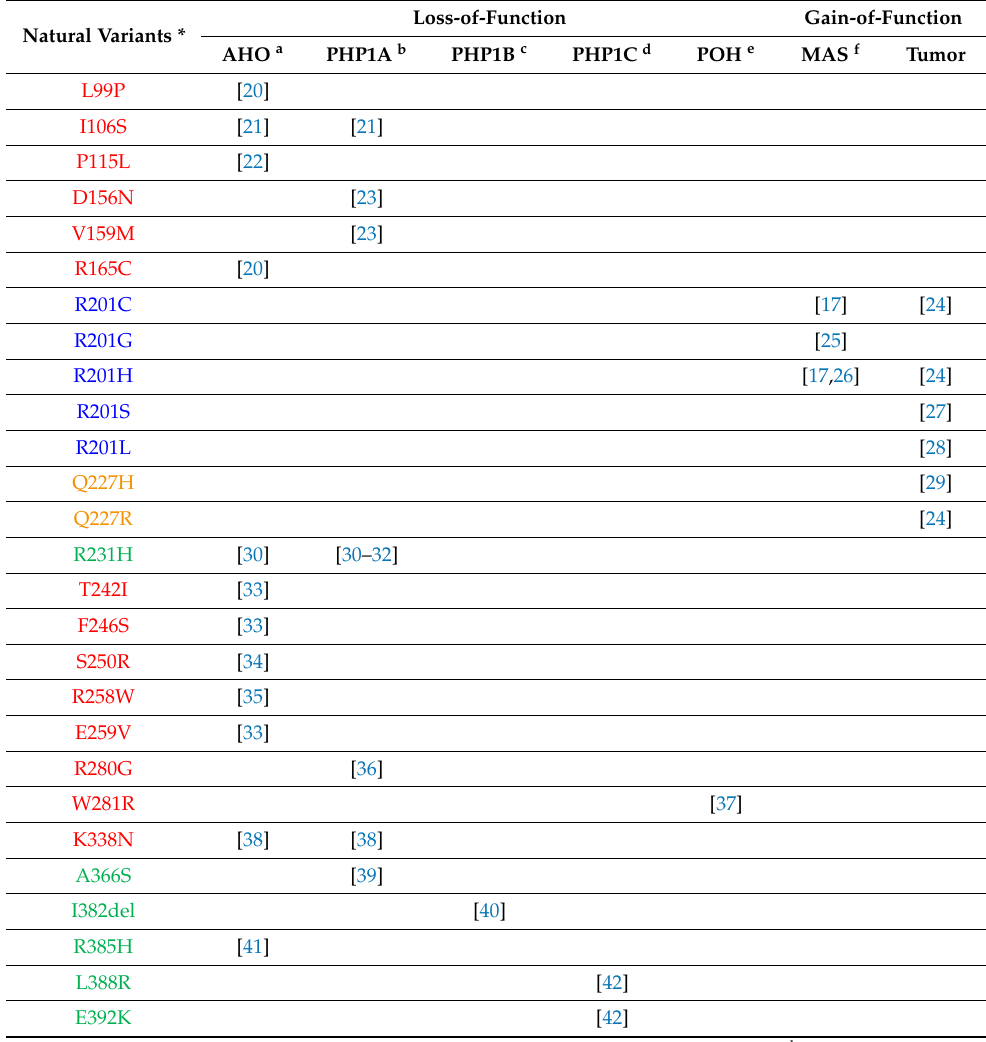
Table 1. Natural variants reported in G α